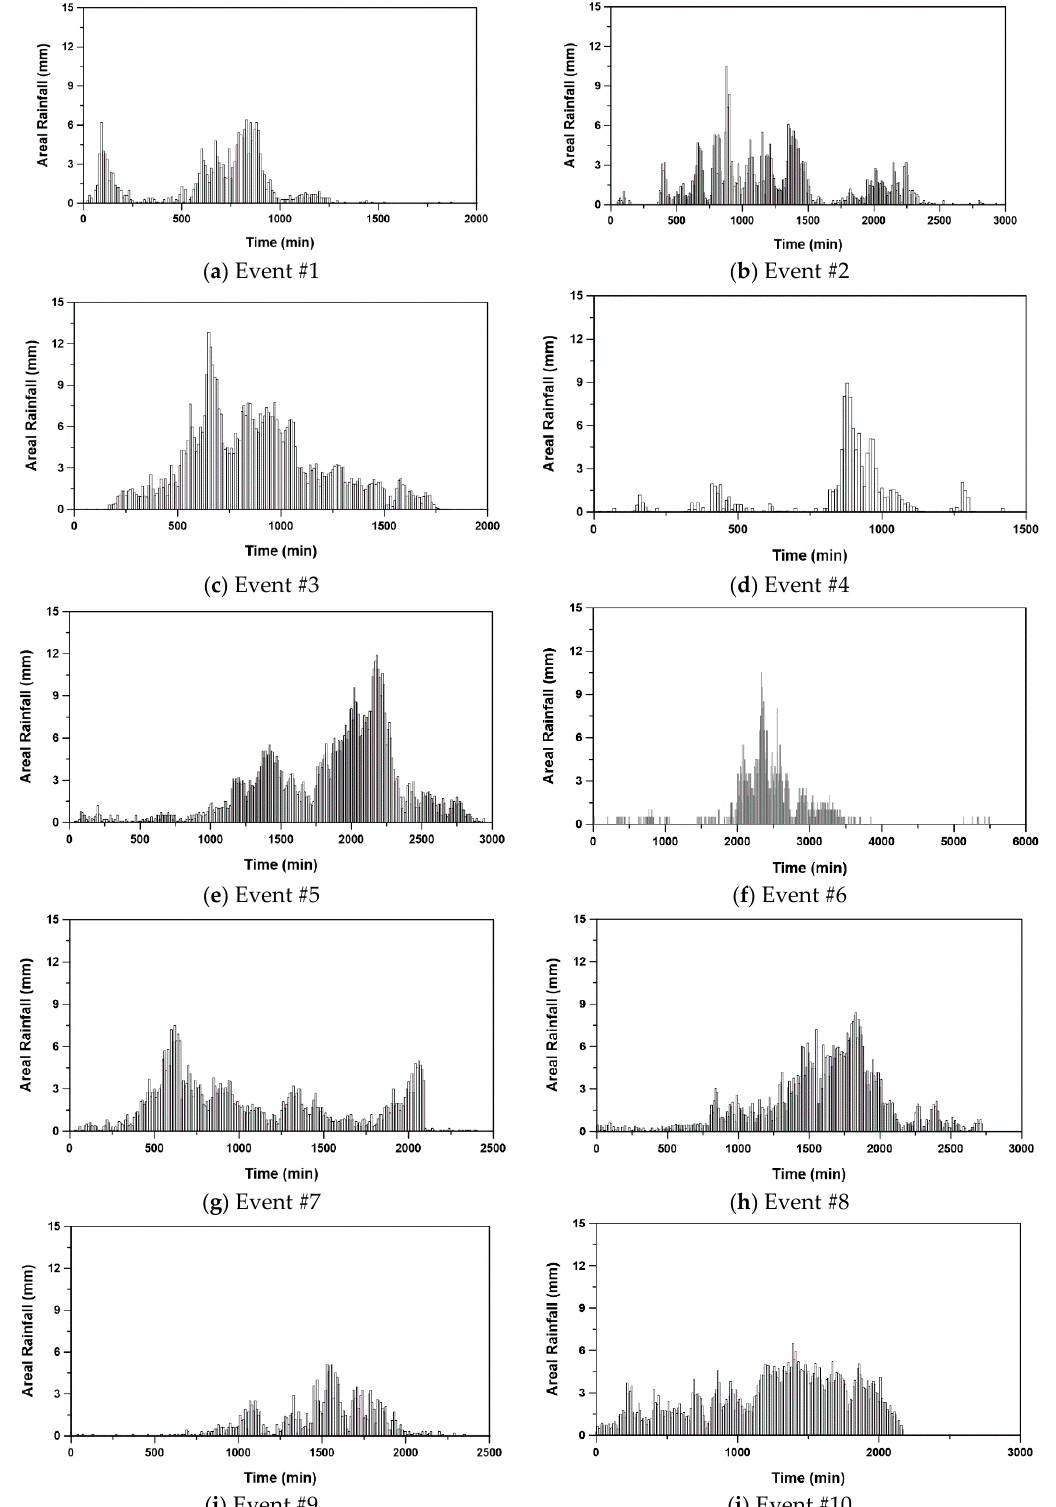
Figure 4. Temporal distribution of the areal ‐ average rainfall over the Hancheon basin for the rainfall events considered in this study.